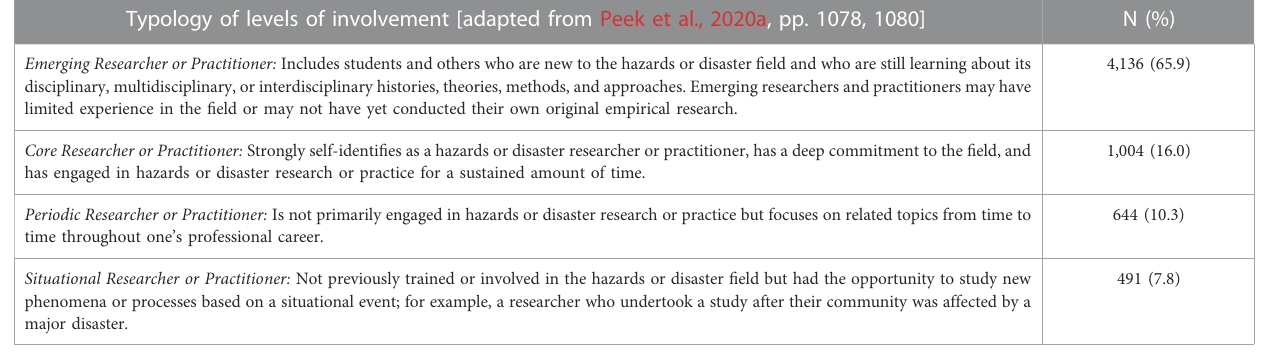
TABLE 2 CONVERGE Training Module registrants by level of involvement in the fi eld.